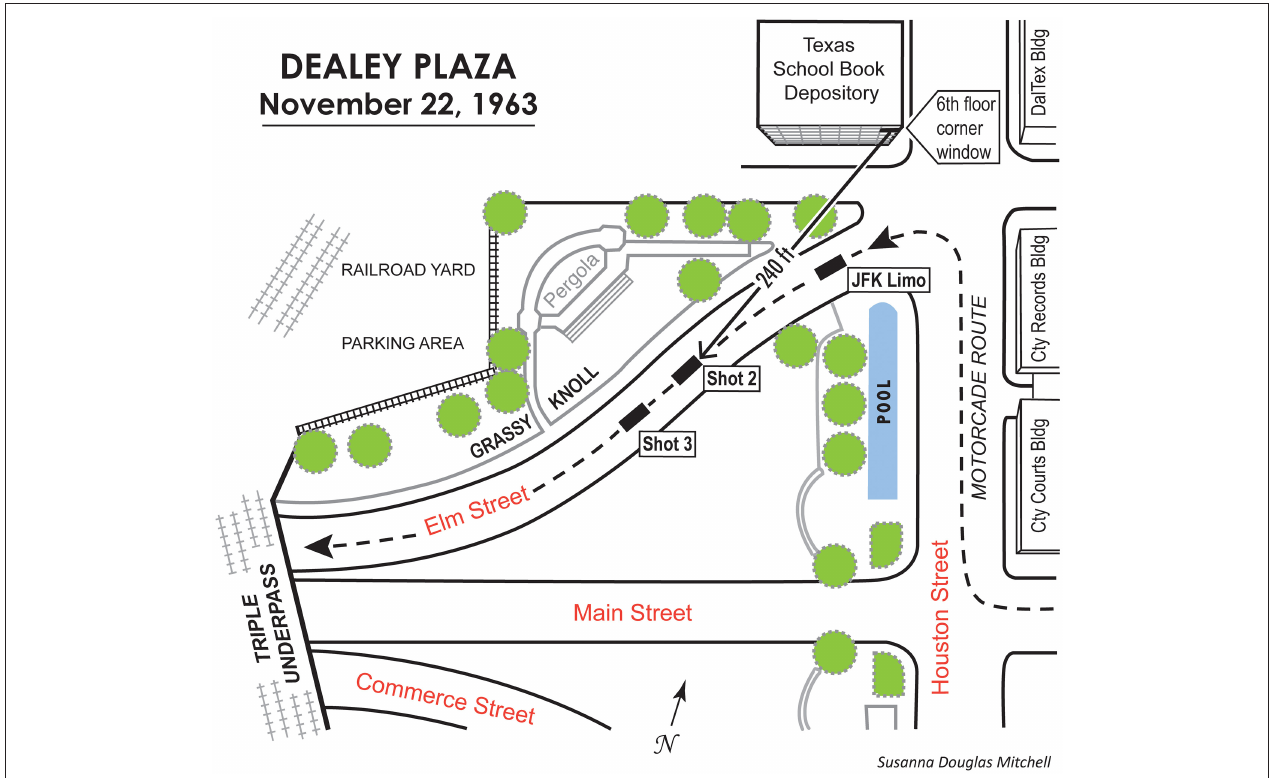
FIGURE 1 | Diagram of Dealey Plaza, showing the path of the motorcade (dashed line); the location of the assassin on the 6th floor of the TSBD; three locations of the presidential limousine corresponding roughly to its locations when the three shots were fired from the TSBD; the location of the pergola where A. Zapruder stood while filming the assassination; and other relevant details. Figure adapted from Green (1979) by Susanna Douglas